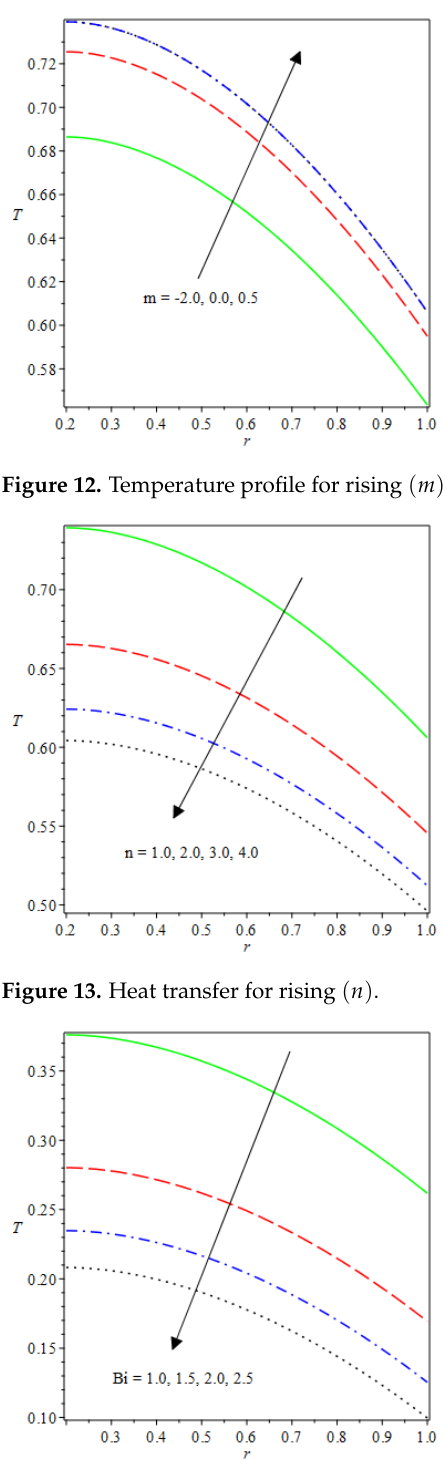
Figure 14. Temperature profile for rising ( Bi )